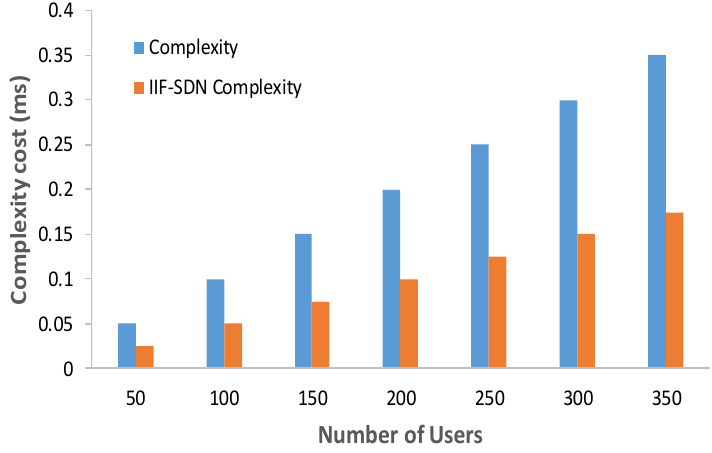
Figure 17. Flow-tables’ updating complexity cost.